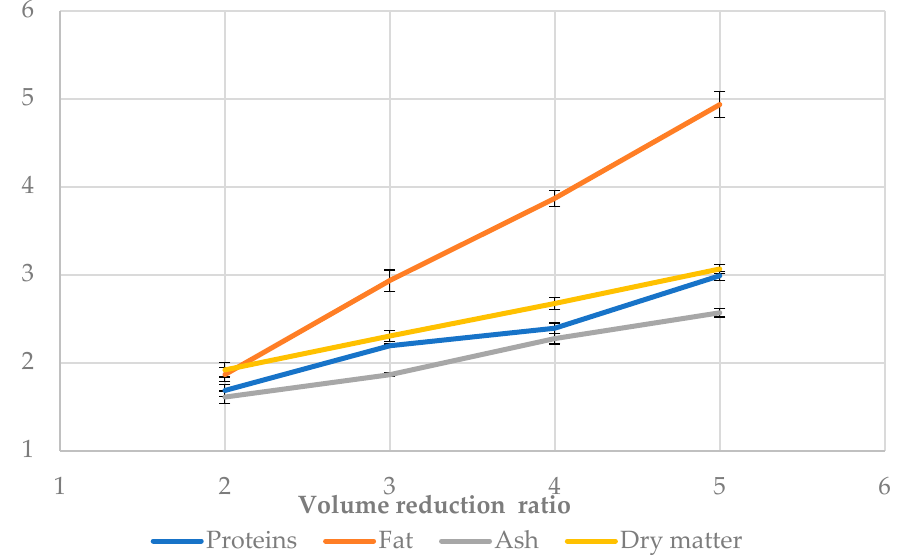
Figure 4. Concentration factor at different volume reduction ratios during ultrafiltration of sweet buttermilk.